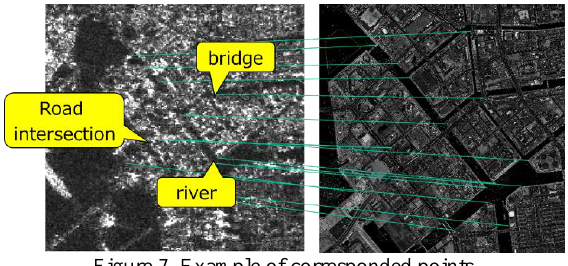
Figure 7. Example of corresponded points